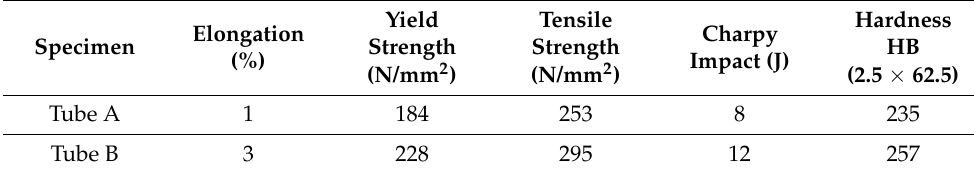
Table 2. The results of tensile strength, impact, and hardness tests.